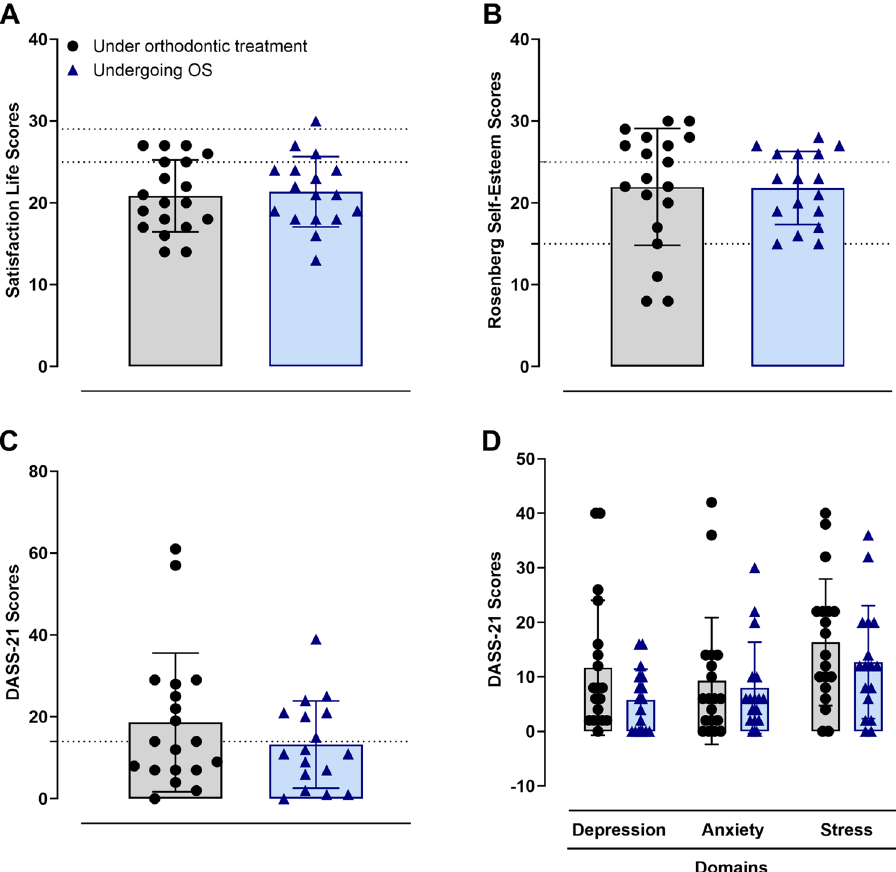
Figure 2. Satisfaction with Life Score ( A ), Rosenberg Self-Esteem Score ( B ), Depression Anxiety Stress Scale 21 (DASS-21) total scores ( C ), and DASS-21 domain scores ( D ): depression, anxiety, and stress in the control (n = 19) and test (n = 17) groups. For the Satisfaction with Life Score, the Rosenberg Self-Esteem Score, and the DASS-21 total score, the Unpaired Student’s t-test was performed. As for the DASS-21 domain scores, Two-Way ANOVA was performed. No significant differences were observed between the experimental groups ( p > 0.05). Each column represents the mean ± SD, and the N of each group is depicted in the scatter dot